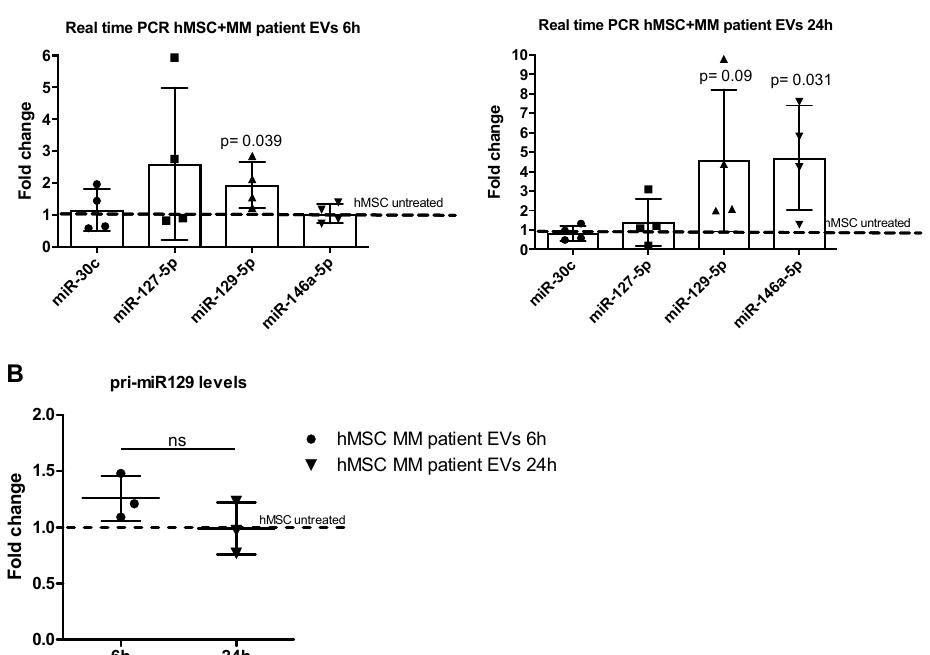
Figure 4. ( A ) Real-time PCR analyses for miR-30c, miR-127-5p, miR-129-5p and miR-146a-5p were performed on hMSCs incubated for 6 (left panel) and 24h (right panel) with EVs from the bone marrow plasma of MM patients (n = 4). Data were normalized for snoU6. Values are expressed as Fold Change in miRNA expression that occurred in cells treated with EVs versus untreated hMSCs (dotted line). ( B ) The Real-Time PCR analyses of pri-miR-129 were performed on hMSCs incubated for 6 and 24h with EVs from the bone marrow plasma of MM patients (n = 3). Data were normalized for β -actin and values are expressed as Fold Change in the pri-miRNA expression that occurred in cells treated with EVs versus untreated hMSCs. The statistical significance of the di ff erences was analyzed using a two-tailed Student’s t